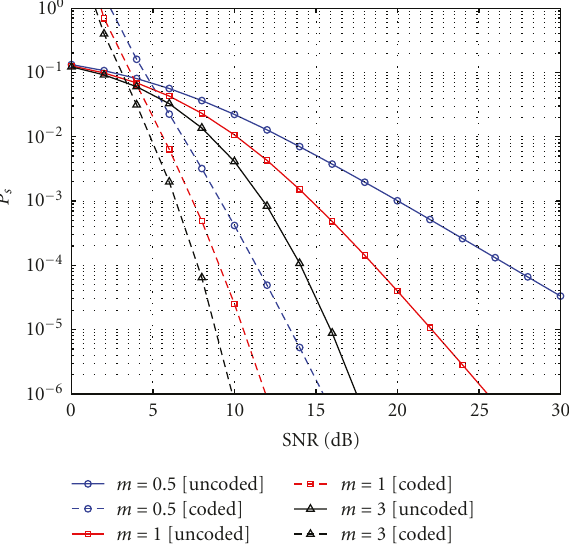
Figure 6: Average symbol error probability versus average SNR per bit for 16-QAM signals with K = 3, Nakagami- m fading channel compared with the performance bound for convolutional